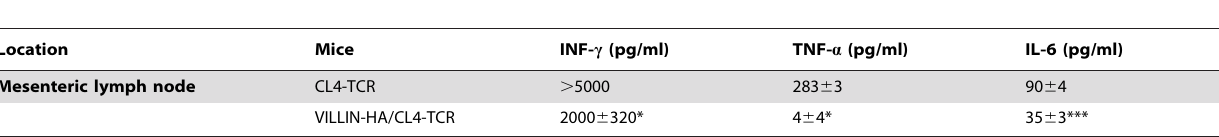
Table 1. Detection of cytokine production by HA-specific CD8 + T cells from MLN of CL4-TCR and VILLIN-HA/CL4-TCR transgenic mice by Cytometric Bead Array.